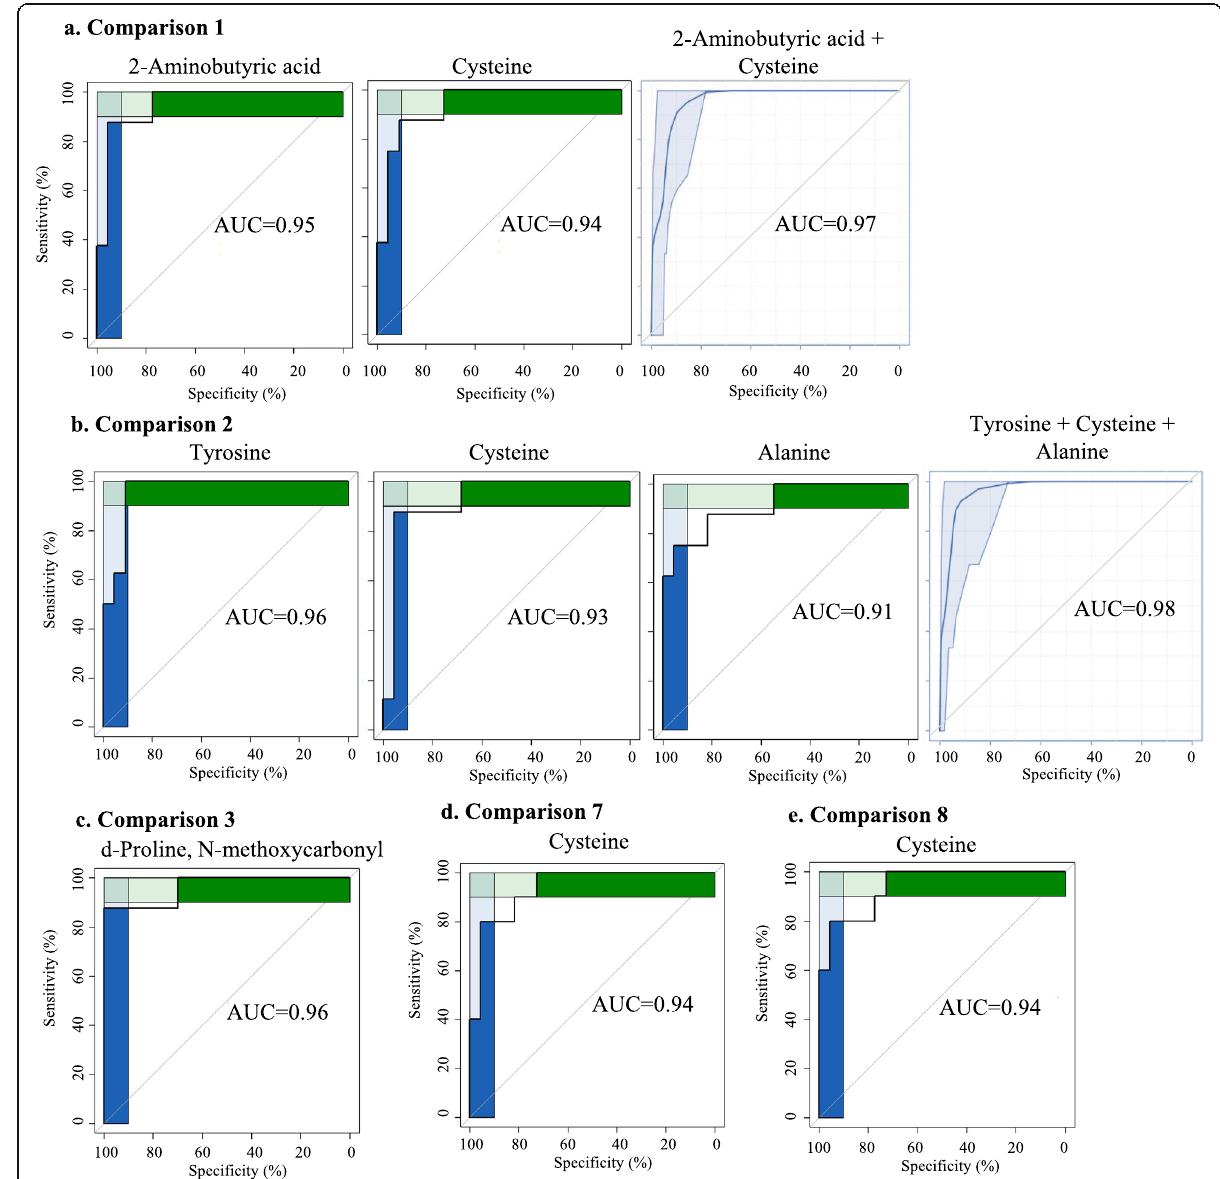
Fig. 6 Hair metabolites with good predictive ability for the corresponding comparisons, with an area under the receiver operating characteristic (ROC) curve greater than 0.9. Pairwise comparisons are conducted between the following twin groups; a) Comparison 1: T2&3 sIUGR-S vs Control. The image on the right-hand side is a multivariate ROC curve combining 2-aminobutyric acid and cysteine; b) Comparison 2: T2&3 sIUGR-L vs Control; c) . Comparison 3: T2&3 sIUGR-S vs T1 sIUGR-S. The image on the right-hand side is a multivariate ROC curve combining tyrosine, cysteine, and alanine; d) . Comparison 7: T1 sIUGR-S vs Control; e) . Comparison 8: T1 sIUGR-L vs Control. List of abbreviations; sIUGR = Selective intrauterine growth restriction; L = Larger twin; S = Smaller twin; T1 = Normal umbilical artery flow; T2&3 = Abnormal umbilical artery